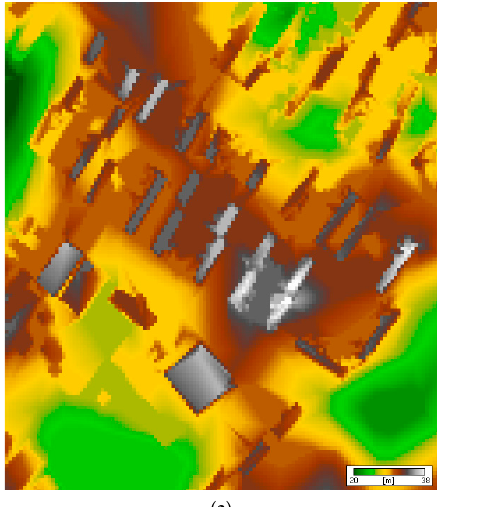
Figure 12. ( a )—Digital urban terrain model of the urban area for WAsP Engineering and WindSim models—Vertical exaggeration of 1.5×; ( b ) Buildings height.